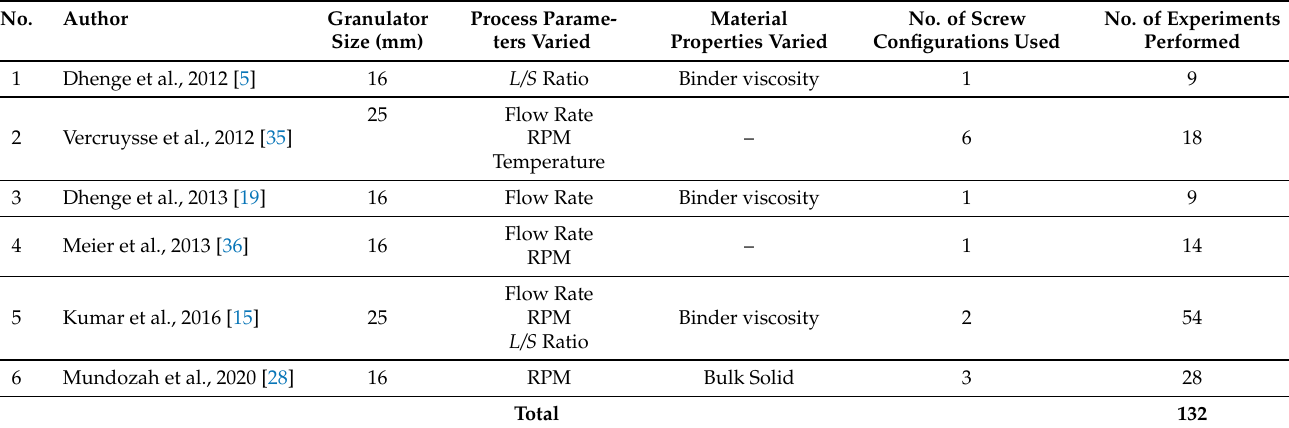
Table 1. Experimental data collected for the development of the modified TSG regime